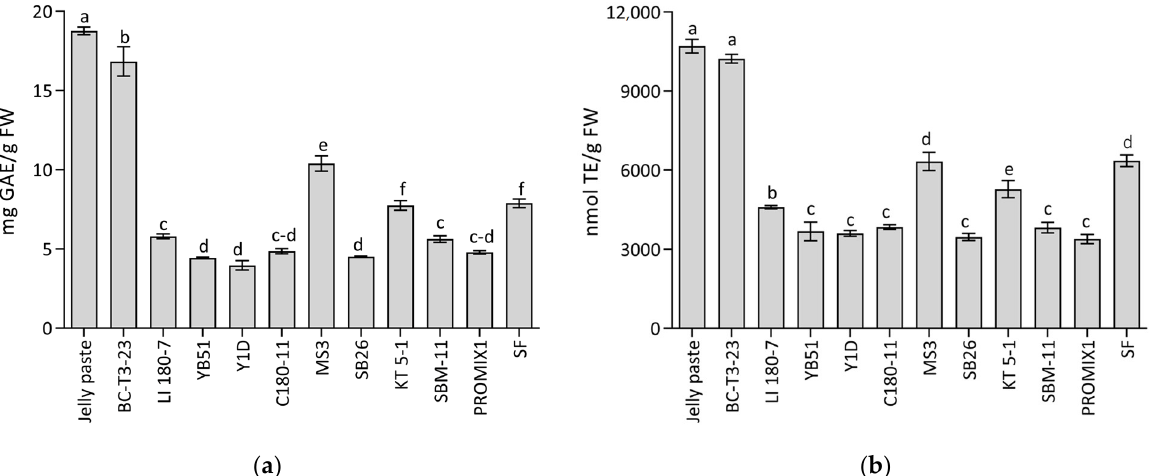
Figure 4. ( a ) Total phenolic contents and ( b ) antioxidant activity in fermented Jellyfish paste samples. Total phenolic content is expressed as mg gallic acid equivalents per g of fresh weight (GAE/ g FW); antioxidant activity is expressed as nmol of TE per g fresh weight (nmol TE/g FW). SF: spontaneous fermentation of uninoculated Jelly paste, as control. Jelly paste inoculated with yeast strains: Y1D, Metschnikowia sp.; YB51, Candida parapsilosis ; BC T3-23, Debaryomyces hansenii ; LI 180-7, Saccharomyces cerevisiae . Jelly paste inoculated with bacterial strains: SB26, Staphylococcus pasteuri ; MS3, Bacillus amyloliquefaciens ; C 180-11, Lactiplantibacillus plantarum , KT 5-1, Leuconostoc mesenteroides ; SBM-11, Lactobacillus sakei , Staphylococcus carnosus and Staphylococcus xylosus ; PROMIX-1, Staphylococcus xylosus . Data were submitted to one-way analysis of variance (ANOVA), Tukey’s post hoc method was applied to determine significant differences among samples ( p < 0.05).